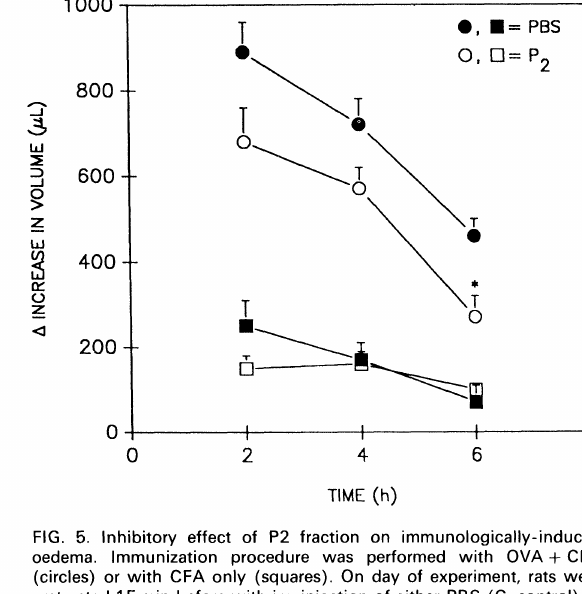
FIG. 5. Inhibitory effect of P2 fraction on immunologically-induced oedema. Immunization procedure was performed with OVA + CFA (circles) or with CFA only (squares). On day of experiment, rats were pretreated 15 min before with i.v. injection of either PBS (C, control) or P2 fraction (P2) and challenged with 100/g i.pl. injection of OVA. Oedema was measured 2, 4 and 6 h. The results are expressed as indicated in Fig. 4. *p < 0.05 as compared to control. Student’s